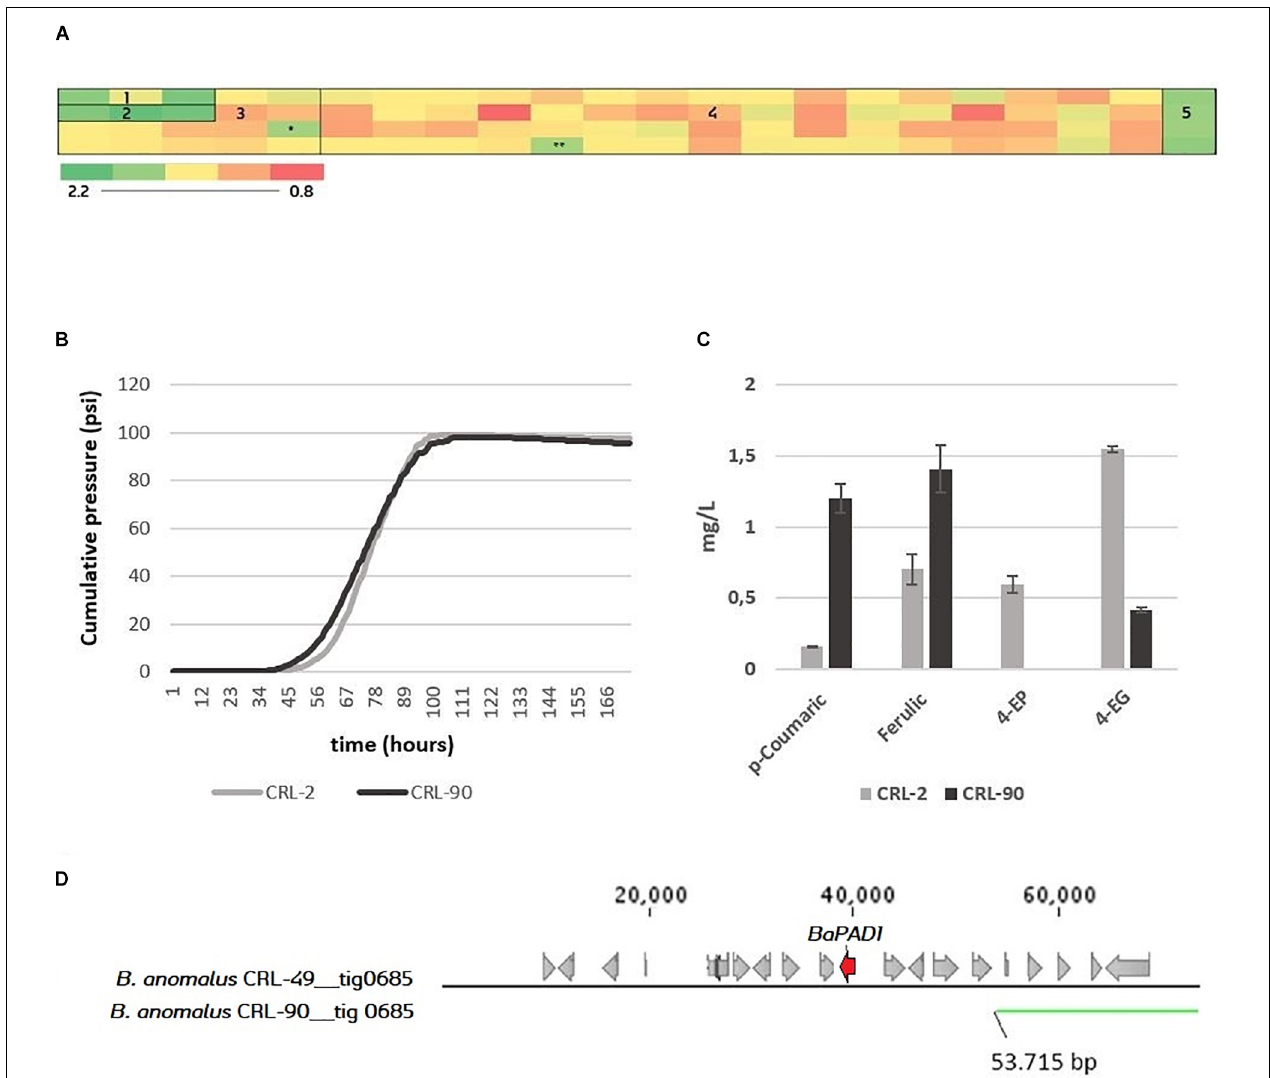
FIGURE 8 | (A) Screening of the 84 Brettanomyces strains for uptake of ferulic acid. Heatmap displays averaged values of OD325 ( n = 3). Standard deviations can be found at Supplementary Table S2 . 1 = B. naardenensis ; 2 = B. custersianus; 3 = B. anomalus ; 4 = B. bruxellensis ; 5 = Blanc; ∗ = CRL-90. ∗∗ = Low growth. For ferulic concentration, see Supplementary Table S3 . (B) Pilsner wort fermentation of CRL-2 and CRL-90. Average values ( n = 2). (C) Phenolic acids (p-coumaric, ferulic) and volatile phenols (4-ethylphenol, 4-ethylguaiacol) in mg/L at the end of fermentation. (D) Genomic setup of CRL-90 compared to the reference CRL-49. The figure has been produced with BLAST tool, comparing the contig nr. 685 where DaPAD1 is present. In Supplementary Table S4 , information about the presence of neighboring ORFs with its respective function is